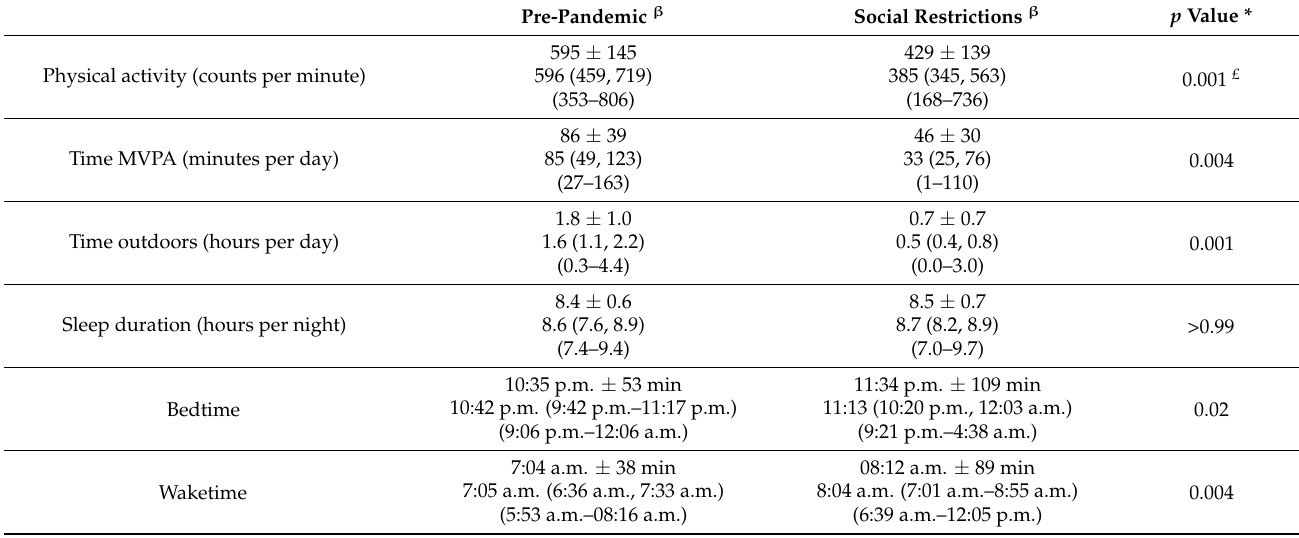
Table 1. Mean and range of daily physical activity and time outdoors (from 7:00 a.m. to 4:30 p.m.), sleep duration, and bed and wake times pre-pandemic and during social restrictions ( n = 19).